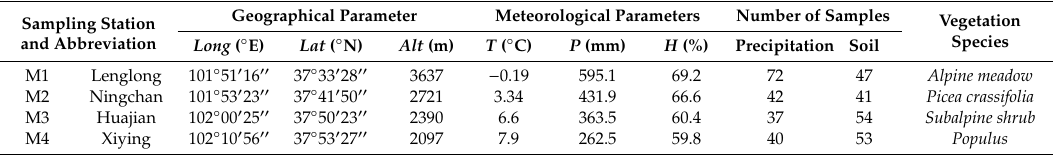
Table 1. Basic data of each sampling station (Long—Longitude, Lat—Latitude, Alt—Altitude, T—Air Temperature, P—Precipitation Amount, h—Relative